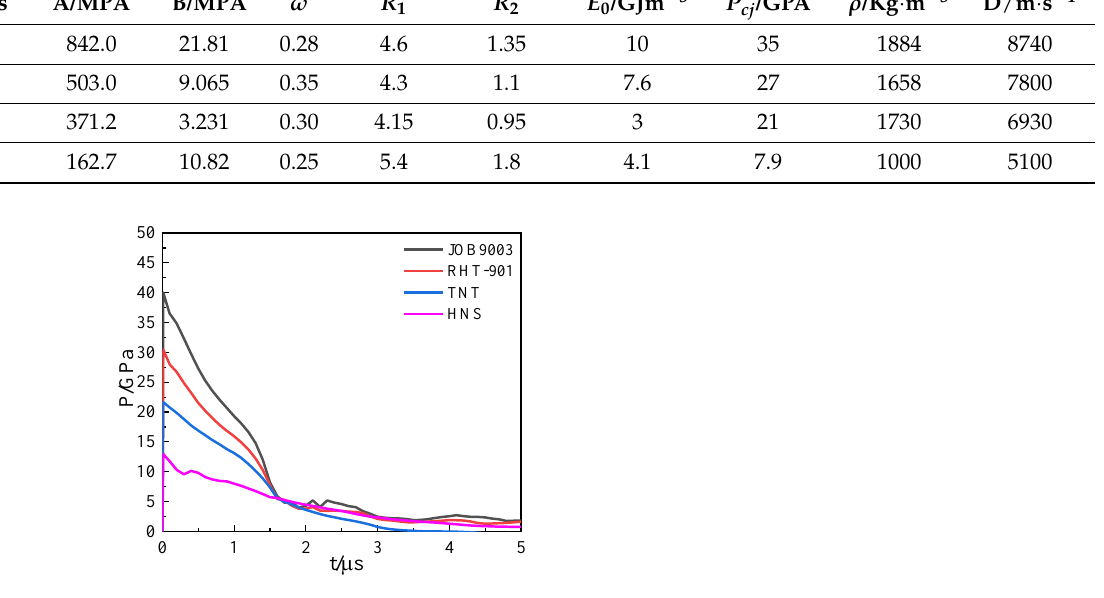
Figure 8. Loading history curves for the inner wall of the cylindrical shell under different explosion pressures.